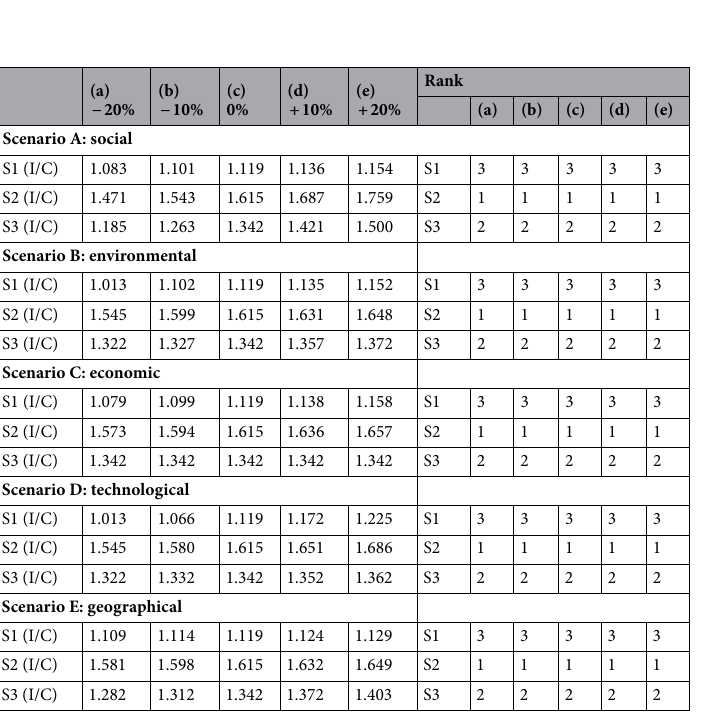
Table 8. The values of I/C and the final ranking results for the different